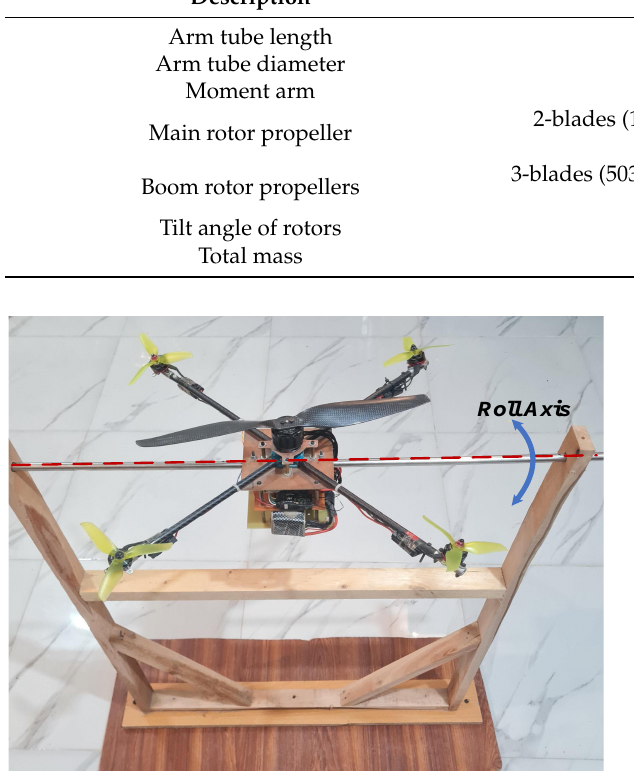
Figure 7. Test rig for roll and pitch axis.